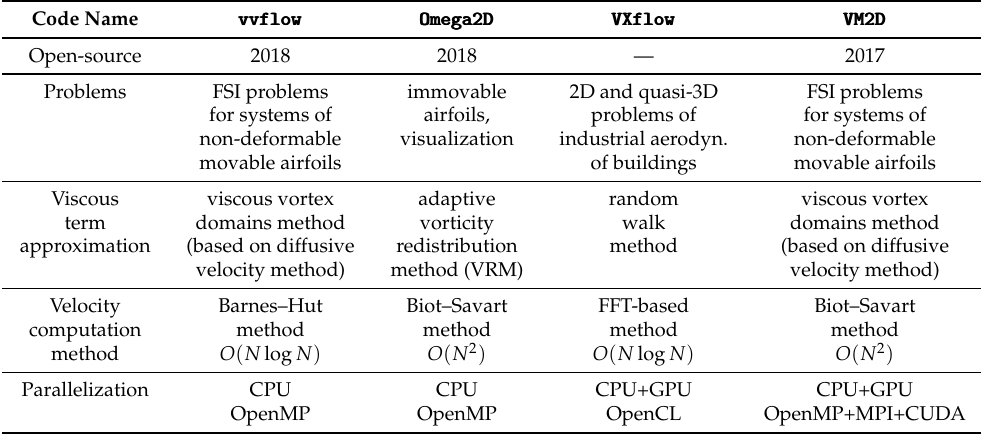
Table 1. Brief comparison of the known